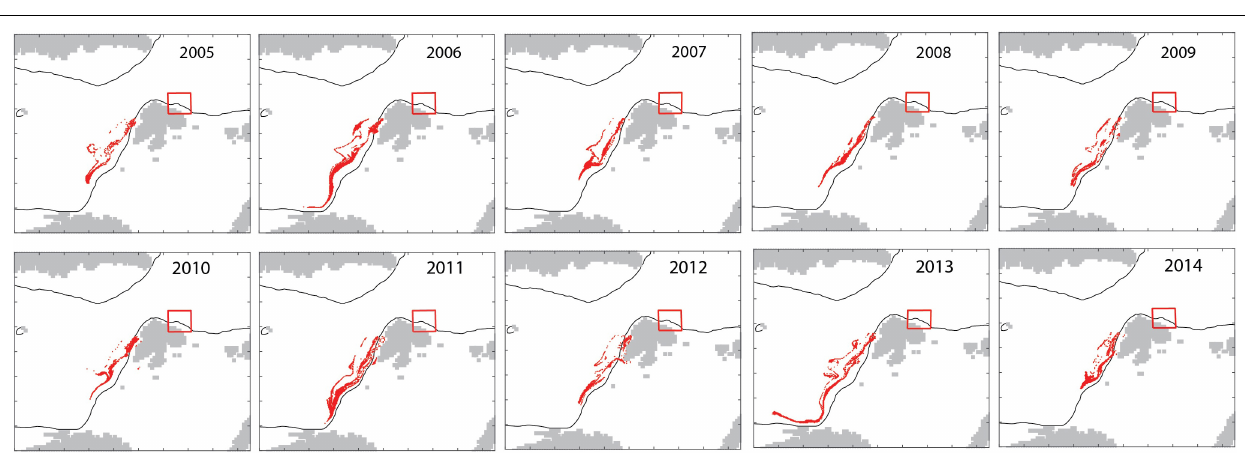
FIGURE 8 | Interannual variability in the April 15 locations (red dots) of mesozooplankton particles that are located north of Svalbard (red box) on October 15 for each year